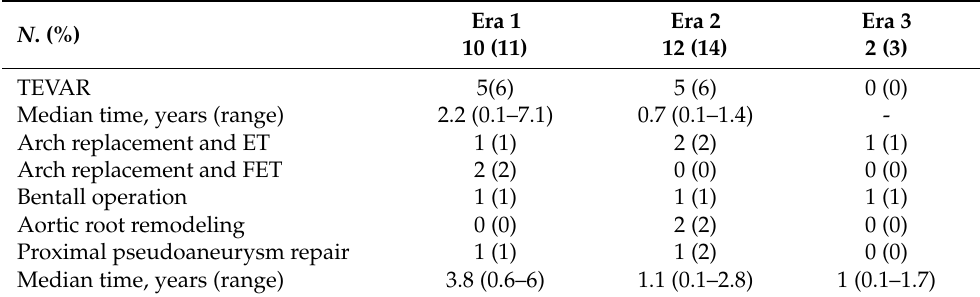
Figure 1. Kaplan–Meier curves showing overall survival according to the era of intervention. Table 6. Reinterventions on thoracic Table 5. Late mortality.